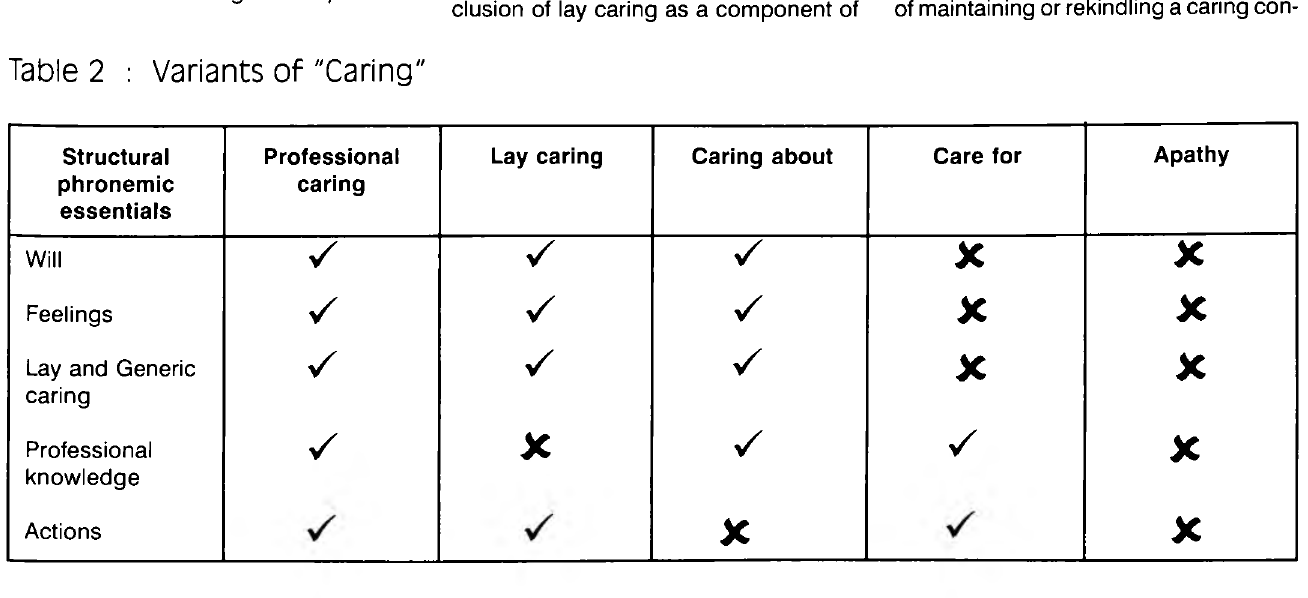
Table 2 : Variants of